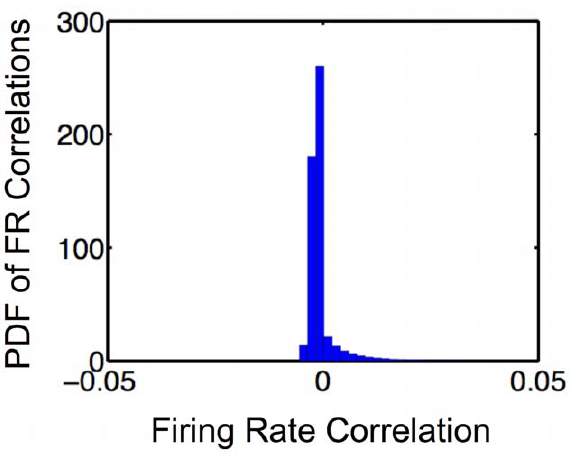
Figure 5. Pairs of SAILnet units have small firing rate correla- tions. The probability distribution function (PDF) of the Pearson’s linear correlation coefficients between the spike-counts of pairs of SAILnet neurons responding to an ensemble of 30,000 natural images is sharply peaked near zero. doi:10.1371/journal.pcbi.1002250.g005 correlation coefficients is affected by the update sizes (learning rates) in the simulation, with larger update sizes leading to a larger variance of the measured distribution. In Fig. 5, the distribution appears truncated on the left. This effect arises because there is a lower bound on the correlation between the neuronal firing rates that arises when the two neurons are never co-active. The low mean firing rate of p ~ 0 : 05 used in our simulation means that this bound is not too far below zero.